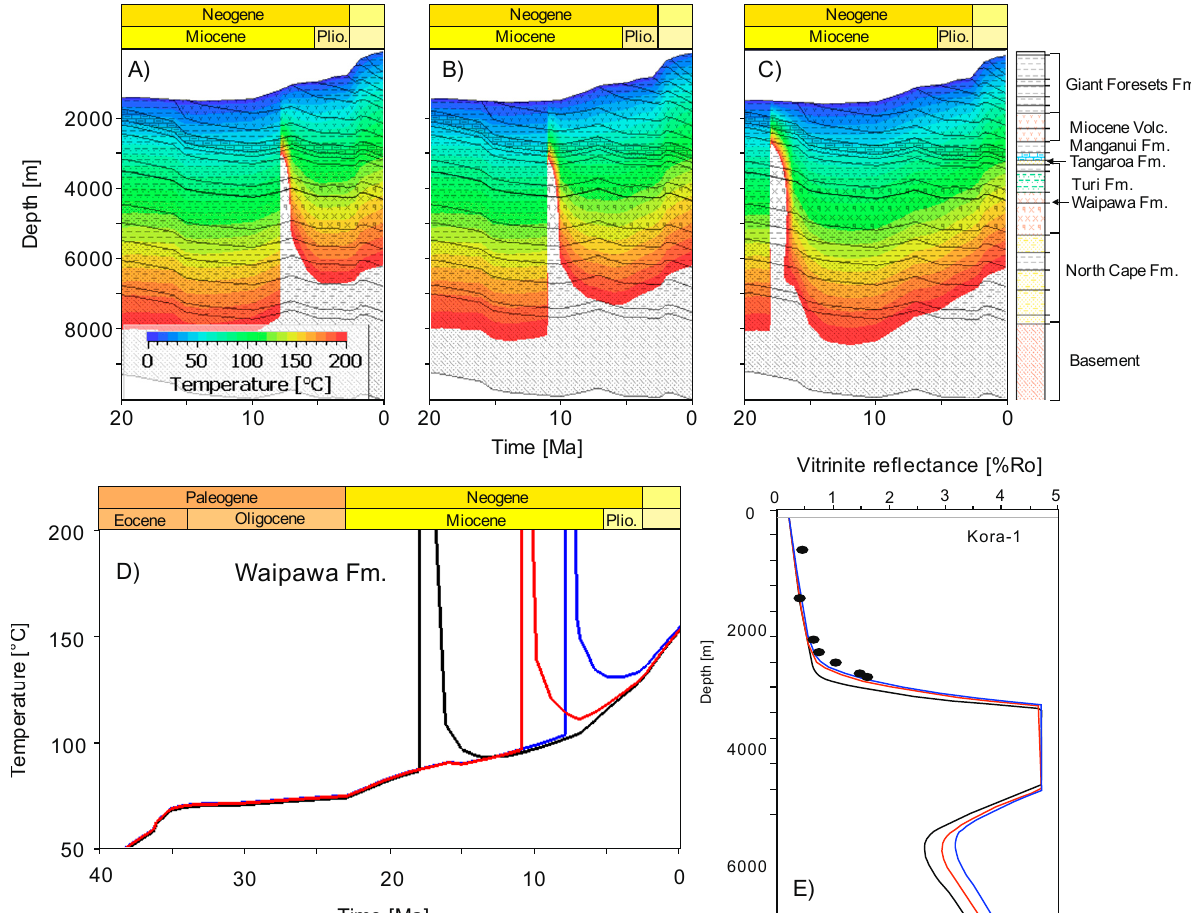
Figure 15. Temperature overlay on the burial history plot for Kora-1 well for Miocene to present time. ( A ) magmatic intrusion in sediments at 8 Ma; ( B ) magmatic intrusion in sediments at 11 Ma; ( C ) magmatic intrusion in sediments at 18 Ma; ( D ) Blue line: magmatic intrusion in sediments at 8 Ma; red line: magmatic intrusion in sediments at 11 Ma; black line: magmatic intrusion in sediments at 18 Ma; ( E ) Maturity curves for three scenarios. Colors of the lines as in D.